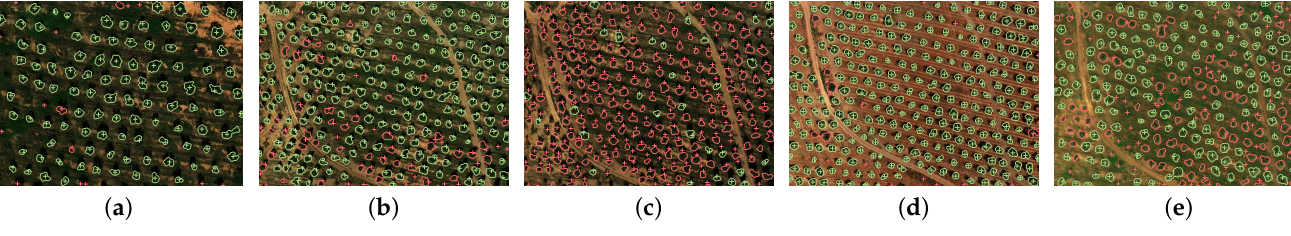
Figure 11. Resulting images obtained and their comparison with the ground truth. Each green mark and contour set indicates a true positive, each red mark indicates a false positive and each red contour indicates a false negative. ( a ) Capture 0. ( b ) Capture 5. ( c ) Capture 8. ( d ) Capture 11. ( e ) Capture